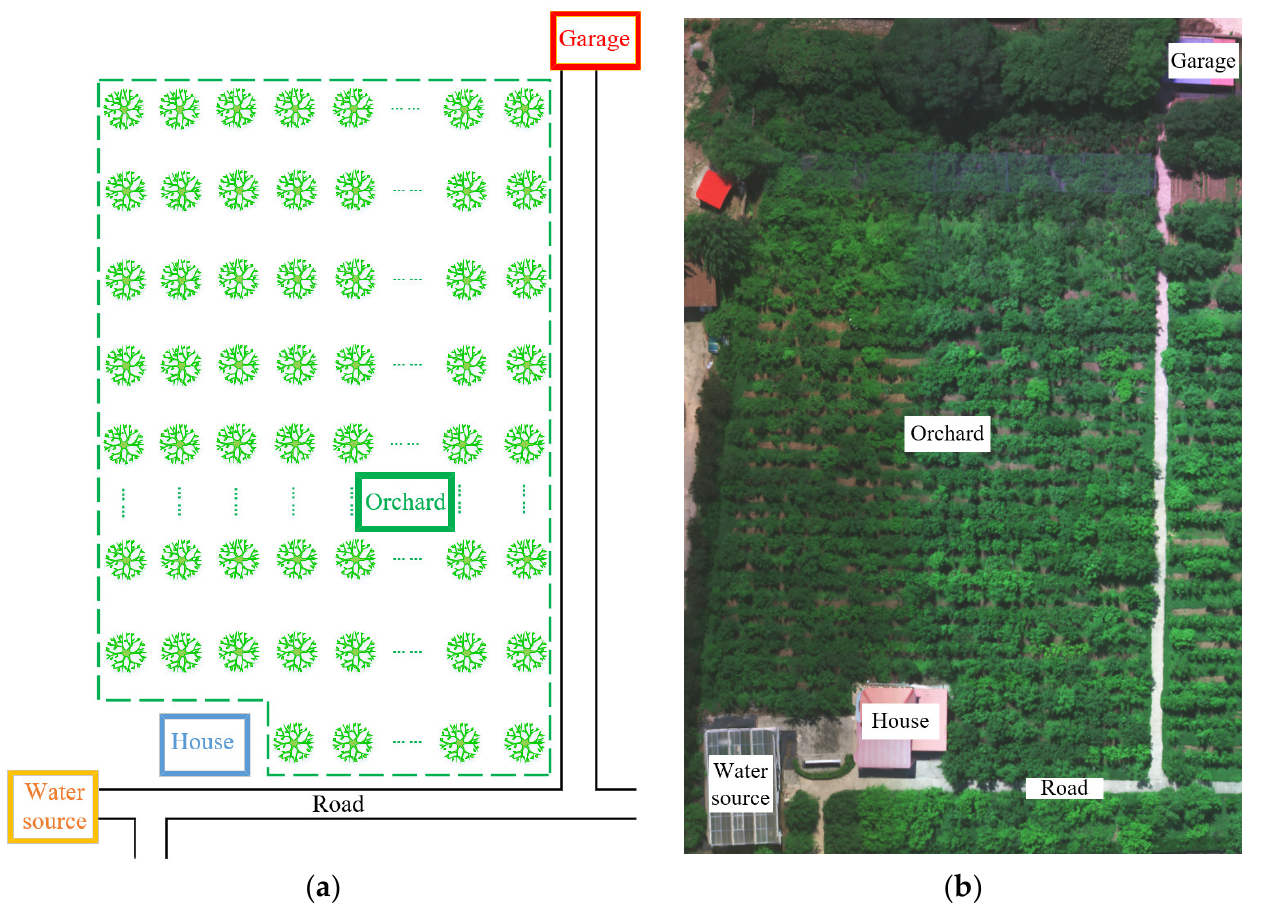
Figure 15. Map of the orchard environment: ( a ) Diagram of the orchard environment; ( b ) physical picture of the orchard environment.